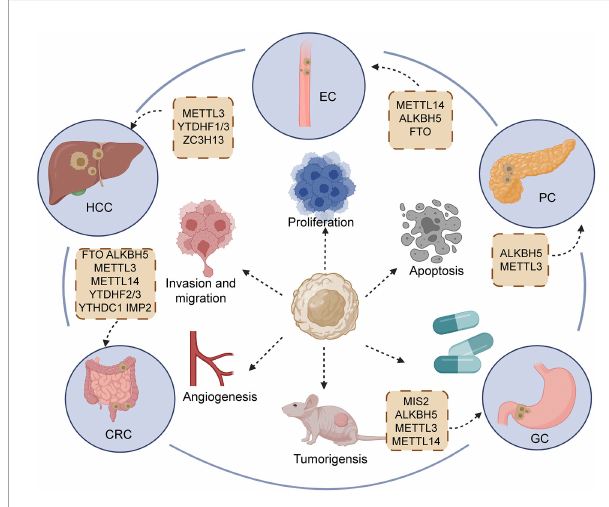
FIGURE 4 Regulators of m6A participating in the initiation and development of main gastrointestinal cancers, including esophageal cancer (EC), hepatocellular carcinoma (HCC), gastric cancer (GC), pancreatic cancers (PC), and colorectal cancer